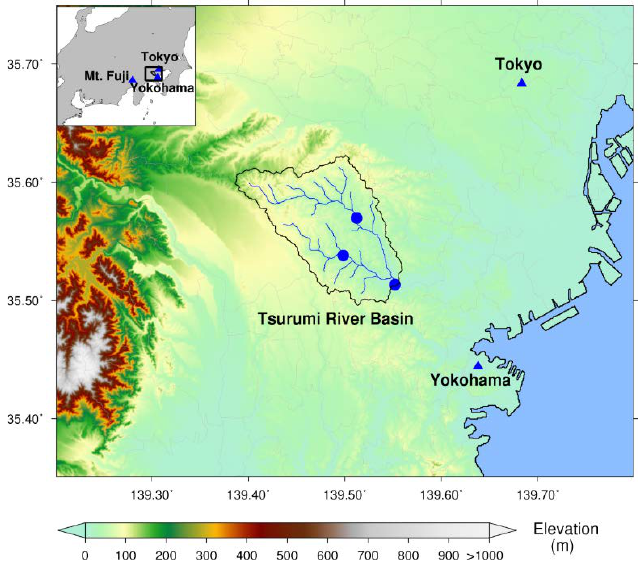
Figure 1. Location of the Tsurumi River Basin in Japan. Blue lines and circles denote the river networks and gauging stations throughout the basin, respectively.